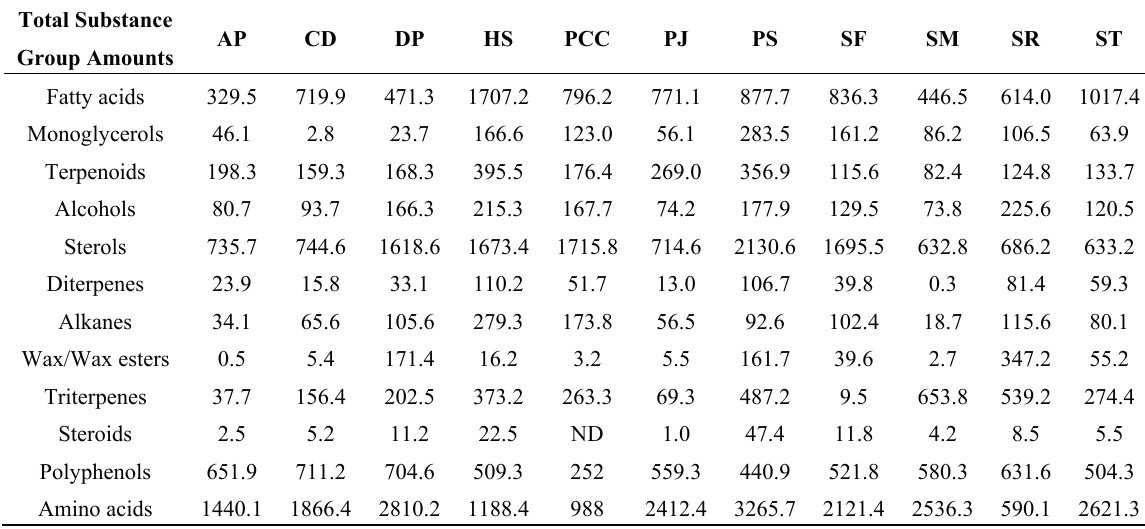
Table 6. Substance groups (mg/100 g dry moss) found in the moss extracts using the GC/MS and LC-TOF-MS